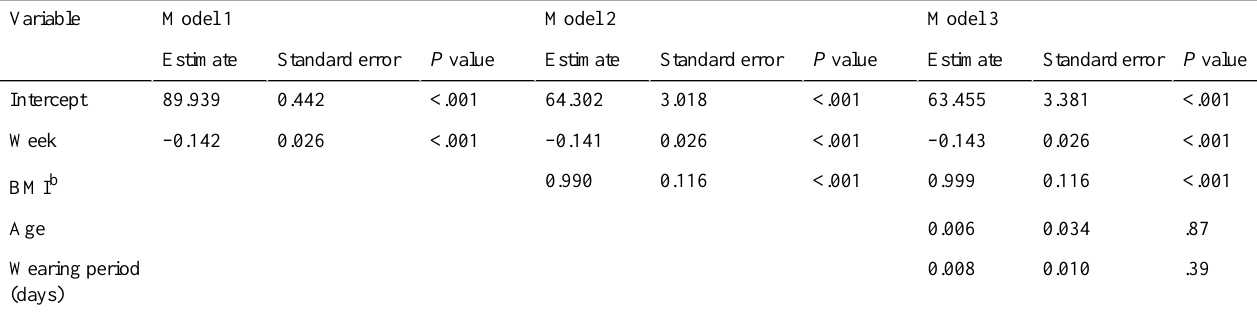
Table 3. Adjusted models for waist circumference using the linear mixed model.